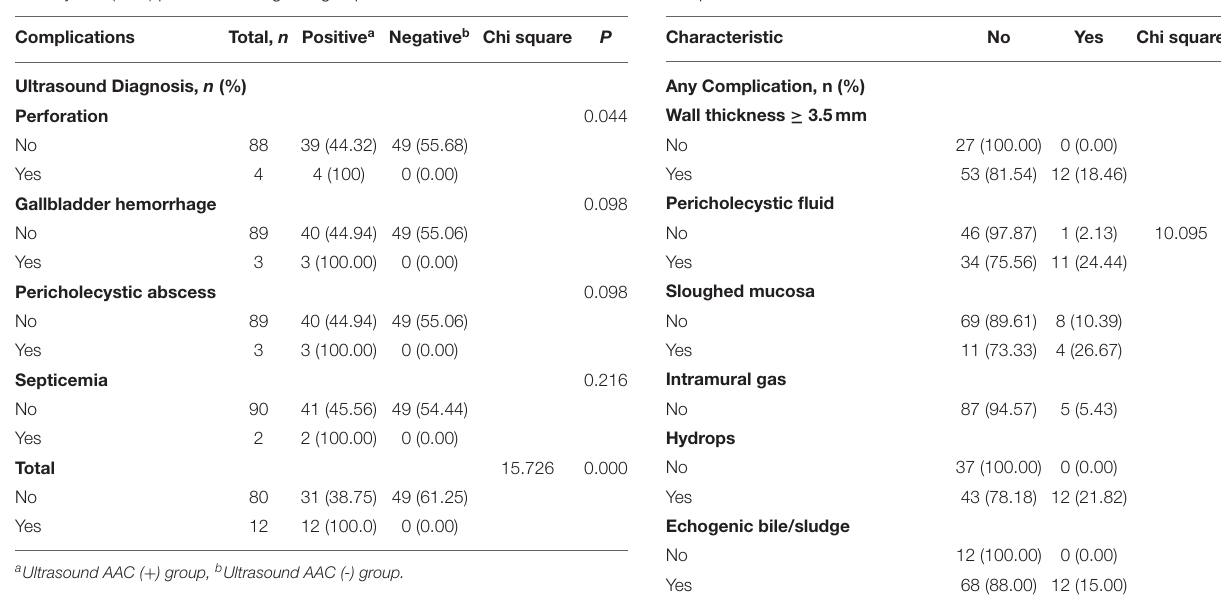
TABLE 4 | Summary of patient characteristics and ultrasound features by complication status.